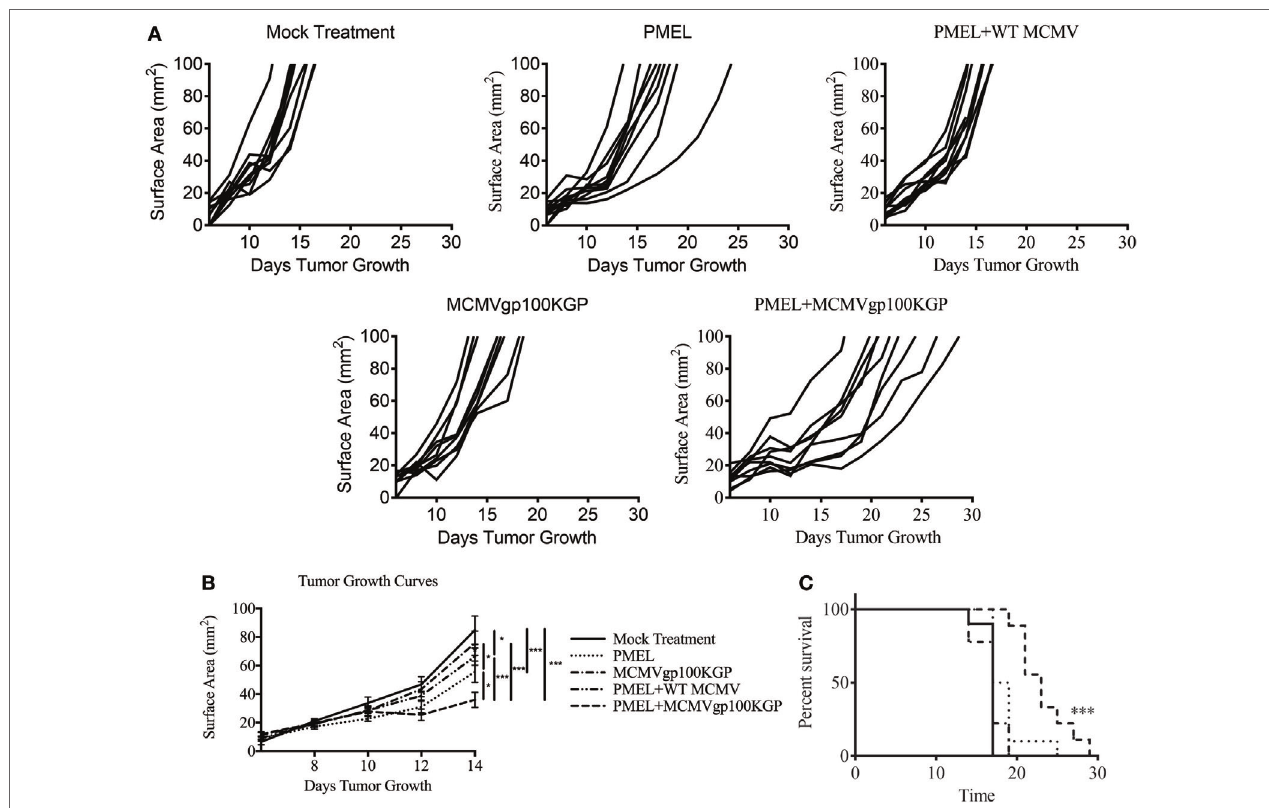
FigUre 4 | Adoptive cell therapy and MCMVgp100KGP vaccination delays B16F10 tumor growth. Wild-type (WT) mice were challenged with B16F10 i.d. and 5 days later were mock treated, treated with PMEL transfer, treated with PMEL transfer i.v. and 10 5 PFU WT MCMV i.p., treated with 10 5 PFU MCMVgp100KGP i.p. alone, or treated with PMEL transfer i.v. and 10 5 PFU MCMVgp100KGP i.p. (a) Tumor growth curves of individual mice treated as shown. (B) Combined tumor growth curves and (c) survival from experiment shown in (a) . Data are accumulated from two independent experiments with n = 9–10 mice/group total. One mouse from the PMEL and MCMVgp100KGP group did not grow a tumor and was excluded. * p < 0.05; *** p <